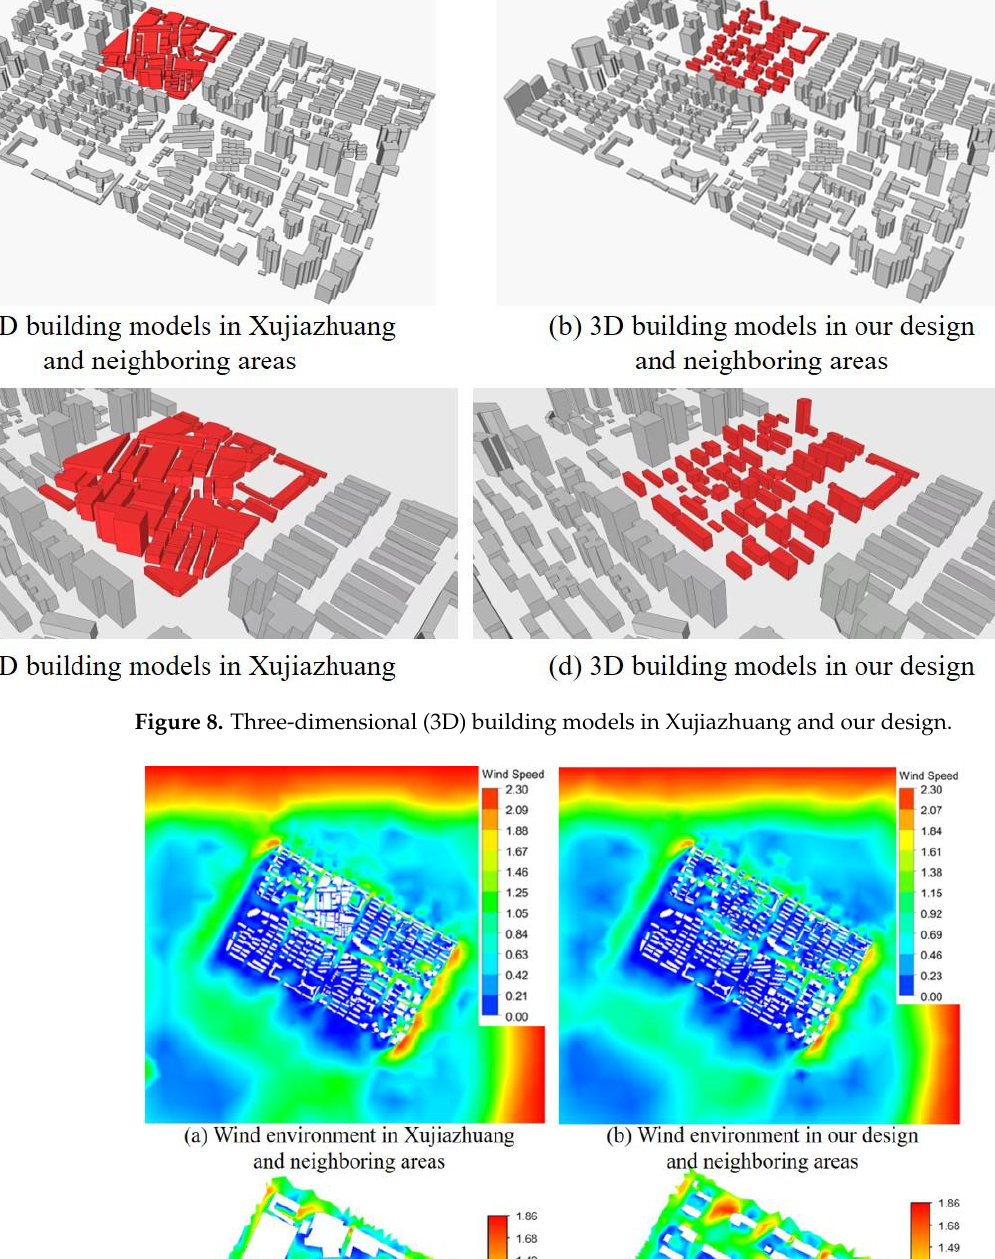
Figure 10. Wind speed distributions in Xujiazhuang and our design. Table 2. Statistics of wind speed in Xujiazhuang and our design. Research Object